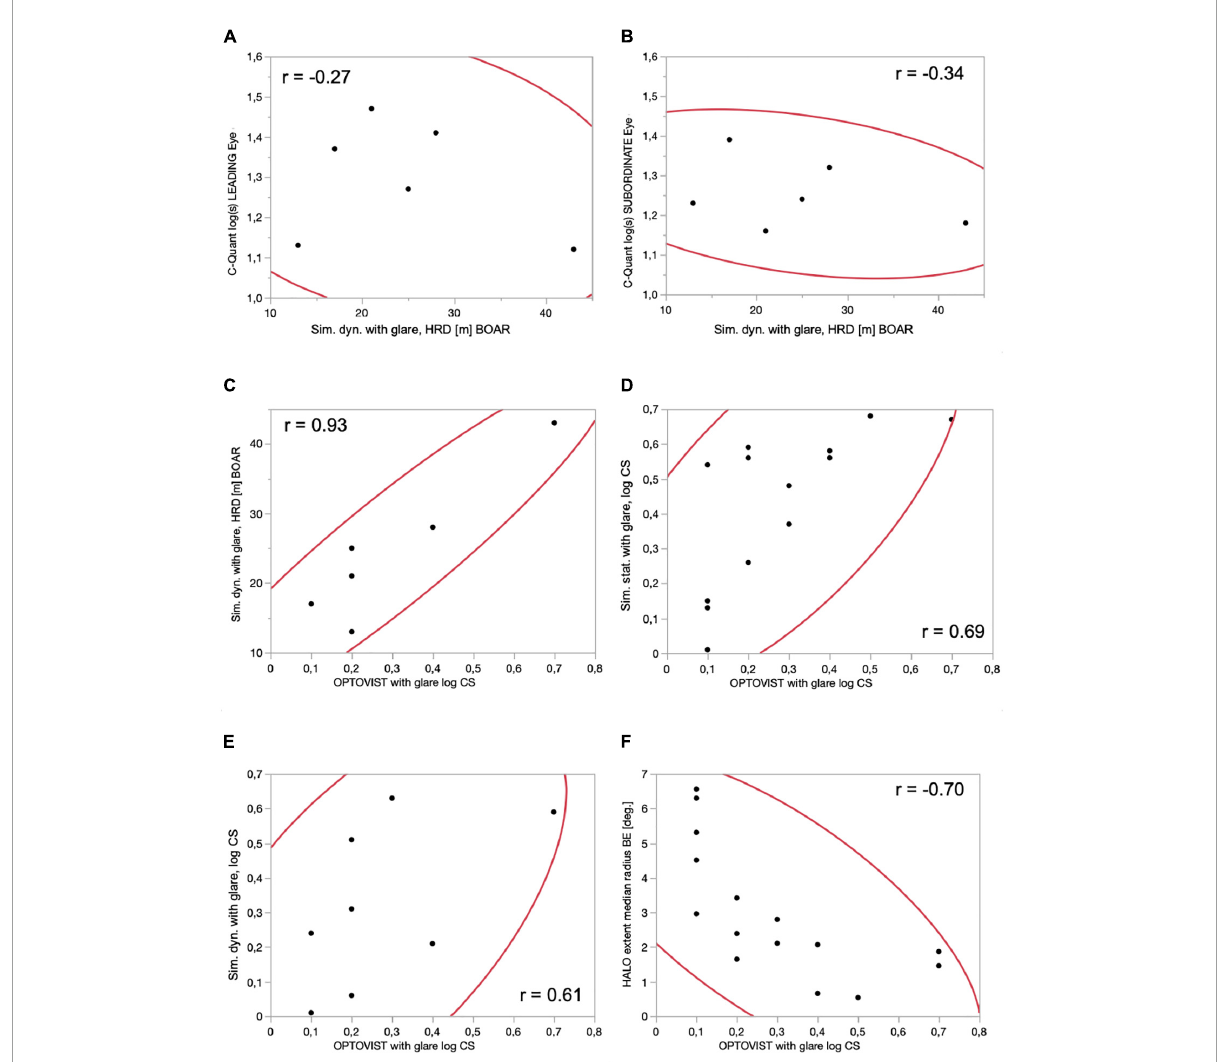
FIGURE3 Correlations between various visual function parameters, with associated 95% confidence intervals (red lines) and correlation coefficients (text). (A) Dynamic conditions, hazard recognition distance (m) BOAR (Weber contrast 87%) vs. straylight perception: C-Quant, log (s), LEADING eye; (B) dynamic conditions, hazard recognition distance (m) BOAR (Weber contrast 87%) vs. straylight perception: C-Quant, log (s), SUBORDINATE eye; (C) contrast sensitivity: Optovist I WITH glare, log CS vs. driving simulator, dynamic conditions, hazard recognition distance (m) BOAR (Weber contrast 87%); (D) contrast sensitivity: Optovist I WITH glare, log CS vs. driving simulator, static conditions, ADAPTIVE thresholding algorithm (BestPEST), log CS; (E) contrast sensitivity: Optovist I WITH glare, log CS vs. driving simulator, dynamic conditions, ADAPTIVE thresholding algorithm (BestPEST), log CS; (F) contrast sensitivity: Optovist I WITH glare, log CS vs. HALO extent (radius in ◦ ), obtained with 8 position Landolt Cs (visual acuity level 0.0125, Weber contrast 80%), moving outward (1 ◦ /s) from a static, slightly eccentric LED glare source emanating from the center of a LED glare source, located 2.5 ◦ left and 0.6 ◦ below the centrally located green fixation